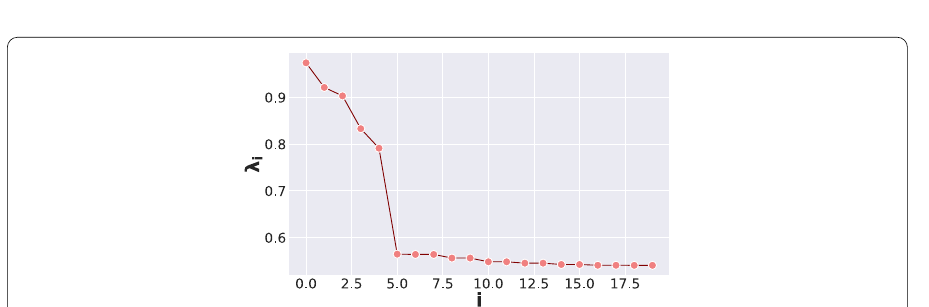
Fig. 5 The eigenvalues of the Koopman operator approximated by graphKKE for 5DynG-100 dataset. The large spectral gap after the fifth eigenvalue reveals the presence of the 5 metastable states in the